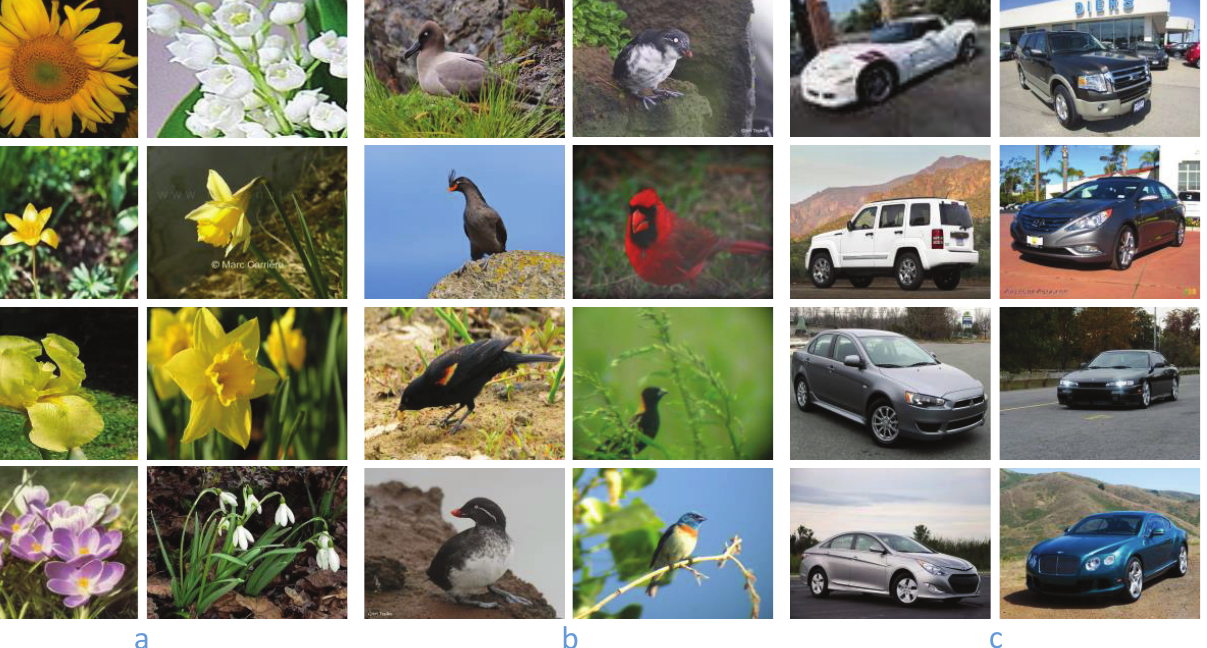
Figure 2. Example images of ( a ) the Flower-102 dataset, ( b ) the CUB-200-2011 dataset, and ( c ) the Cars-196